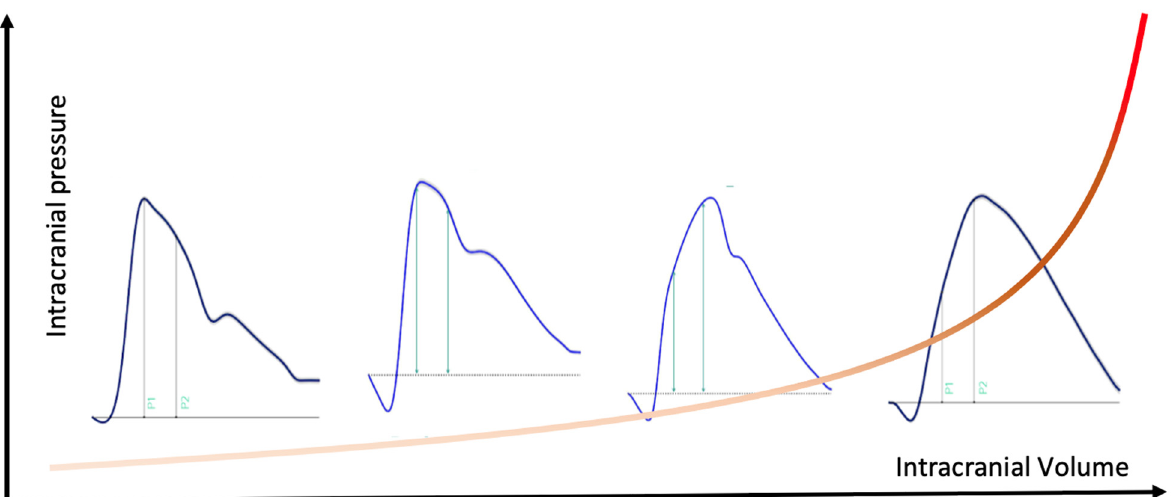
Figure 1. Langfitt’s pressure/volume wave superimposed with ICP waveforms disclosing that as intracranial compliance reduces, a more pyramidal shape is assumed (progressive P2/P1 ratio).